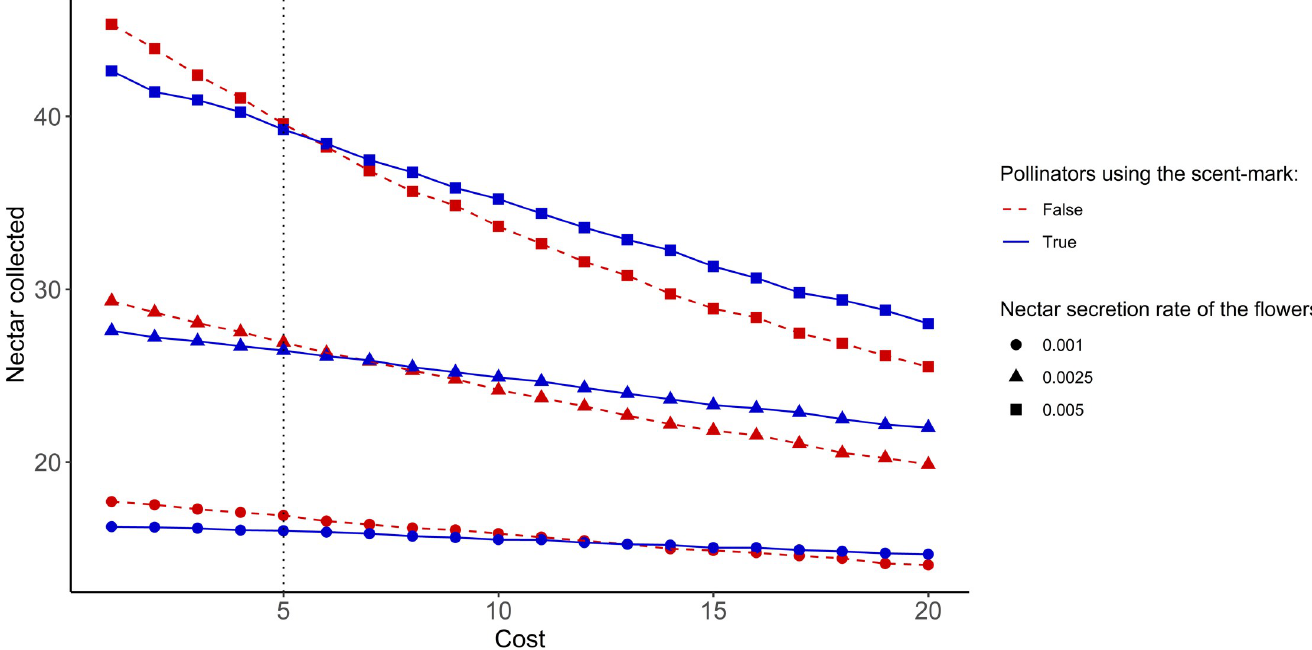
Fig 3. Mean amount of nectar collected by pollinators during the simulation as a function of the cost. The relative number of pollinators per flower was set to 0.1 (low pollinator density). The vertical dotted line represents the default value chosen for our analyses.